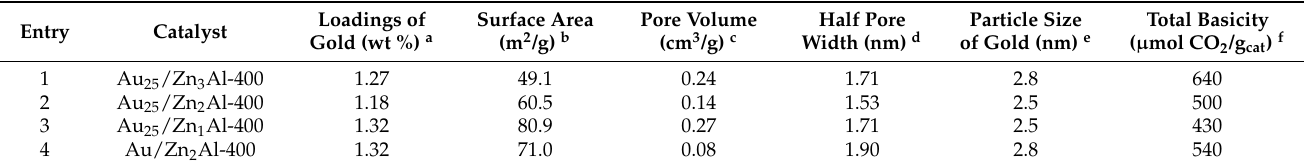
Table 2. Textural properties of Zn-Al-mixed oxides supported gold nanoclusters.